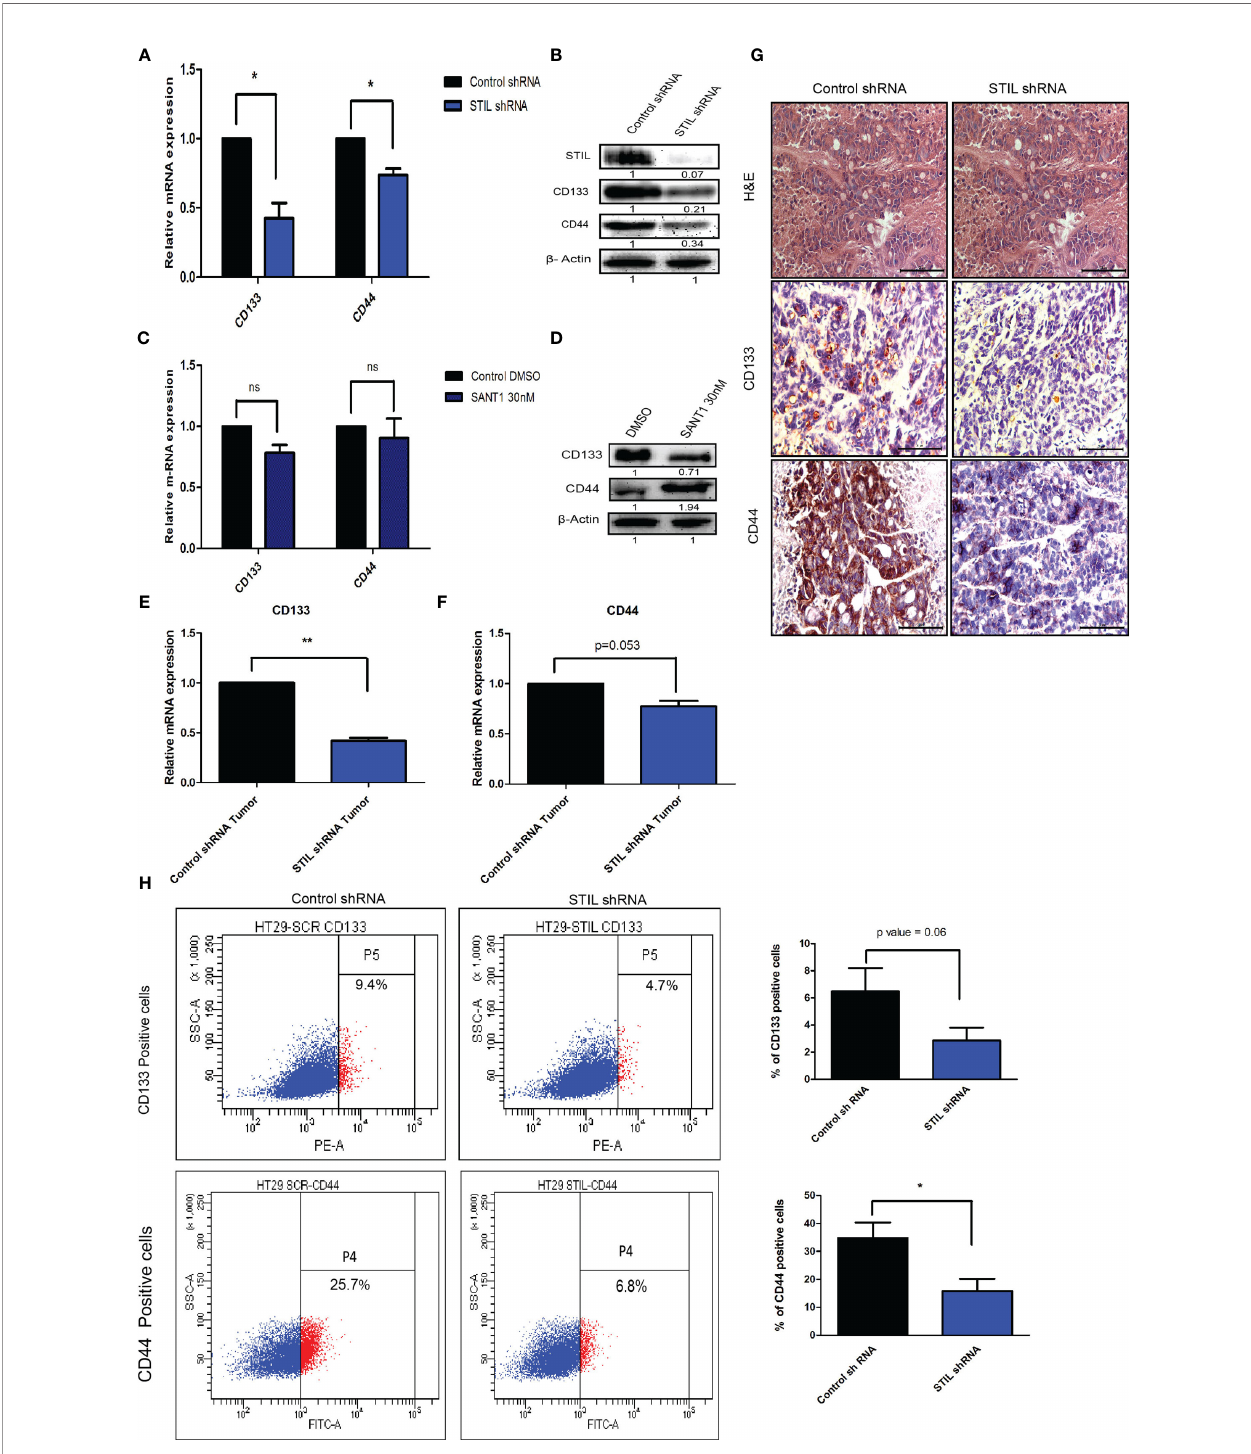
FIGURE 4 | Effect of STIL silencing on CSC markers expression in CRC. (A, B) mRNA and protein level expression of CSC markers upon STIL silencing. (C, D) mRNA and protein level expression of CSC markers upon SANT1 treatment. (E – G) Showing CD133 and CD44 expression in xenograft tumors at mRNA and protein levels, respectively. (H) Dot plot representing % of CD133 and CD44 -positive cells. Unpaired t-test results showing p value ≤ 0.05, ≤ 0.01, ≤ 0.001 are represented by *, **, ***, respectively. Scale bar is 20